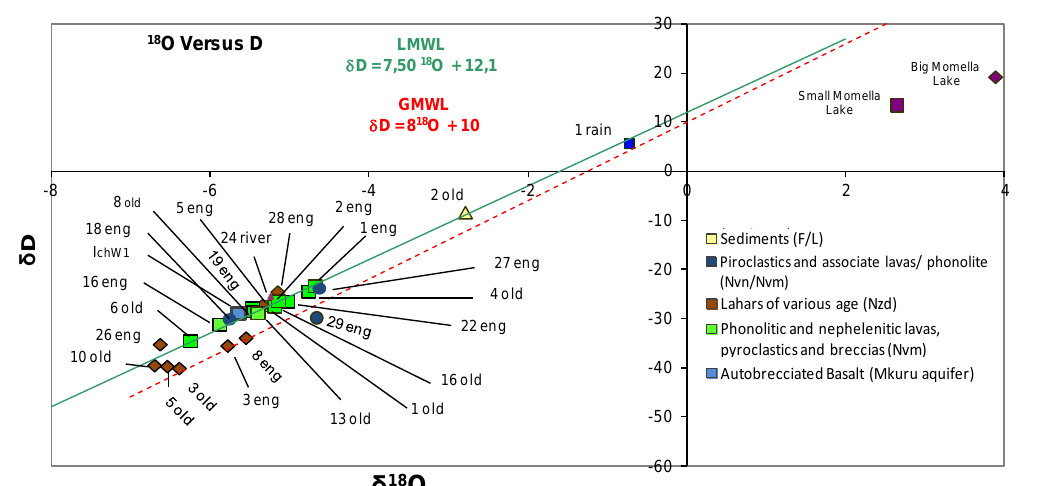
Fig. 7. Plot of 2 H vs. 18 O content. The Local Meteoric Water Line (LMWL) was defined following Dettman et al. (2005), whereas the Global Meteoric Water Line (GMWL) by Craig